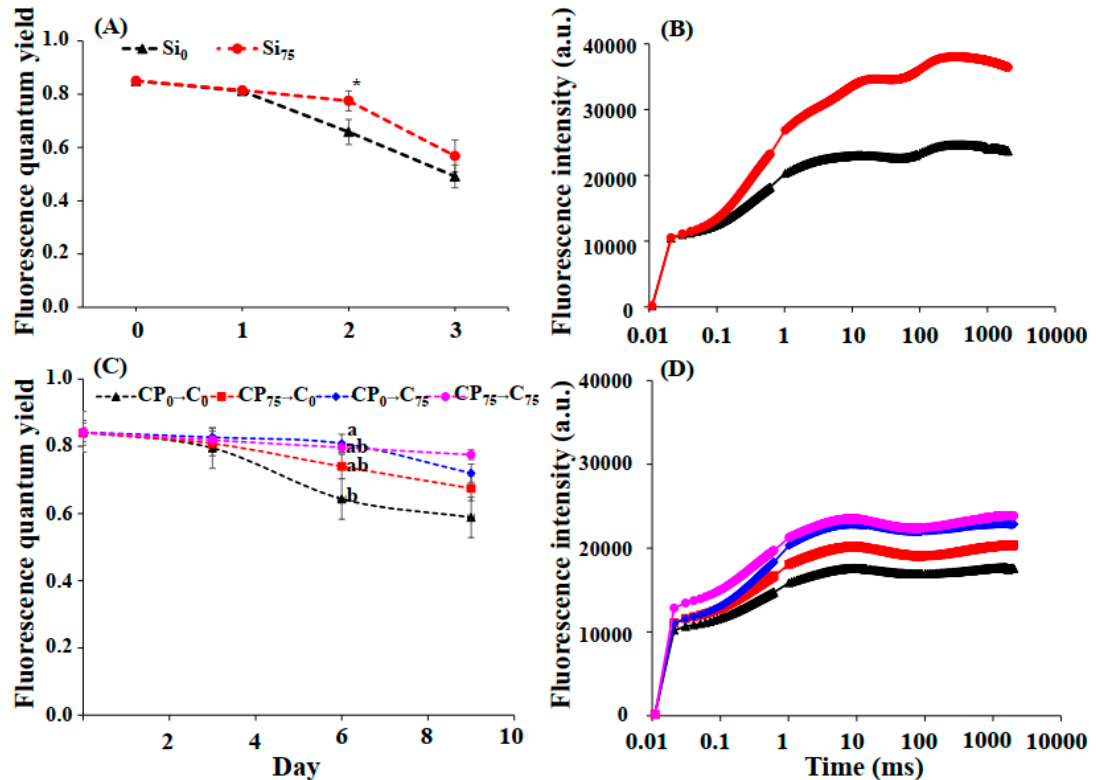
Figure 3. Fluorescence quantum yield and OJIP transient curves of poinsettia subjected to high ( A , B ) and low ( C , D ) temperature stresses. The asterisk and different letters besides error bars indicate significant differences according to Student’s t -test and Duncan’s test, respectively ( p ≤ 0.05). Si 0 , 0 mg ∙ L − 1 Si; Si 75 , 75 mg ∙ L − 1 Si; CP 0 → C 0 , grown with 0 mg ∙ L − 1 Si during cutting propagation and cultivation; CP 75 → C 0 , grown with 75 mg ∙ L − 1 Si during cutting propagation and 0 mg ∙ L − 1 Si during cultivation; CP 0 → C 75 , grown with 0 mg ∙ L − 1 Si during cutting propagation and 75 mg ∙ L − 1 Si during cultivation; CP 75 → C 75 , grown with 75 mg ∙ L − 1 Si during cutting propagation and 75 mg ∙ L − 1 Si during cultivation.